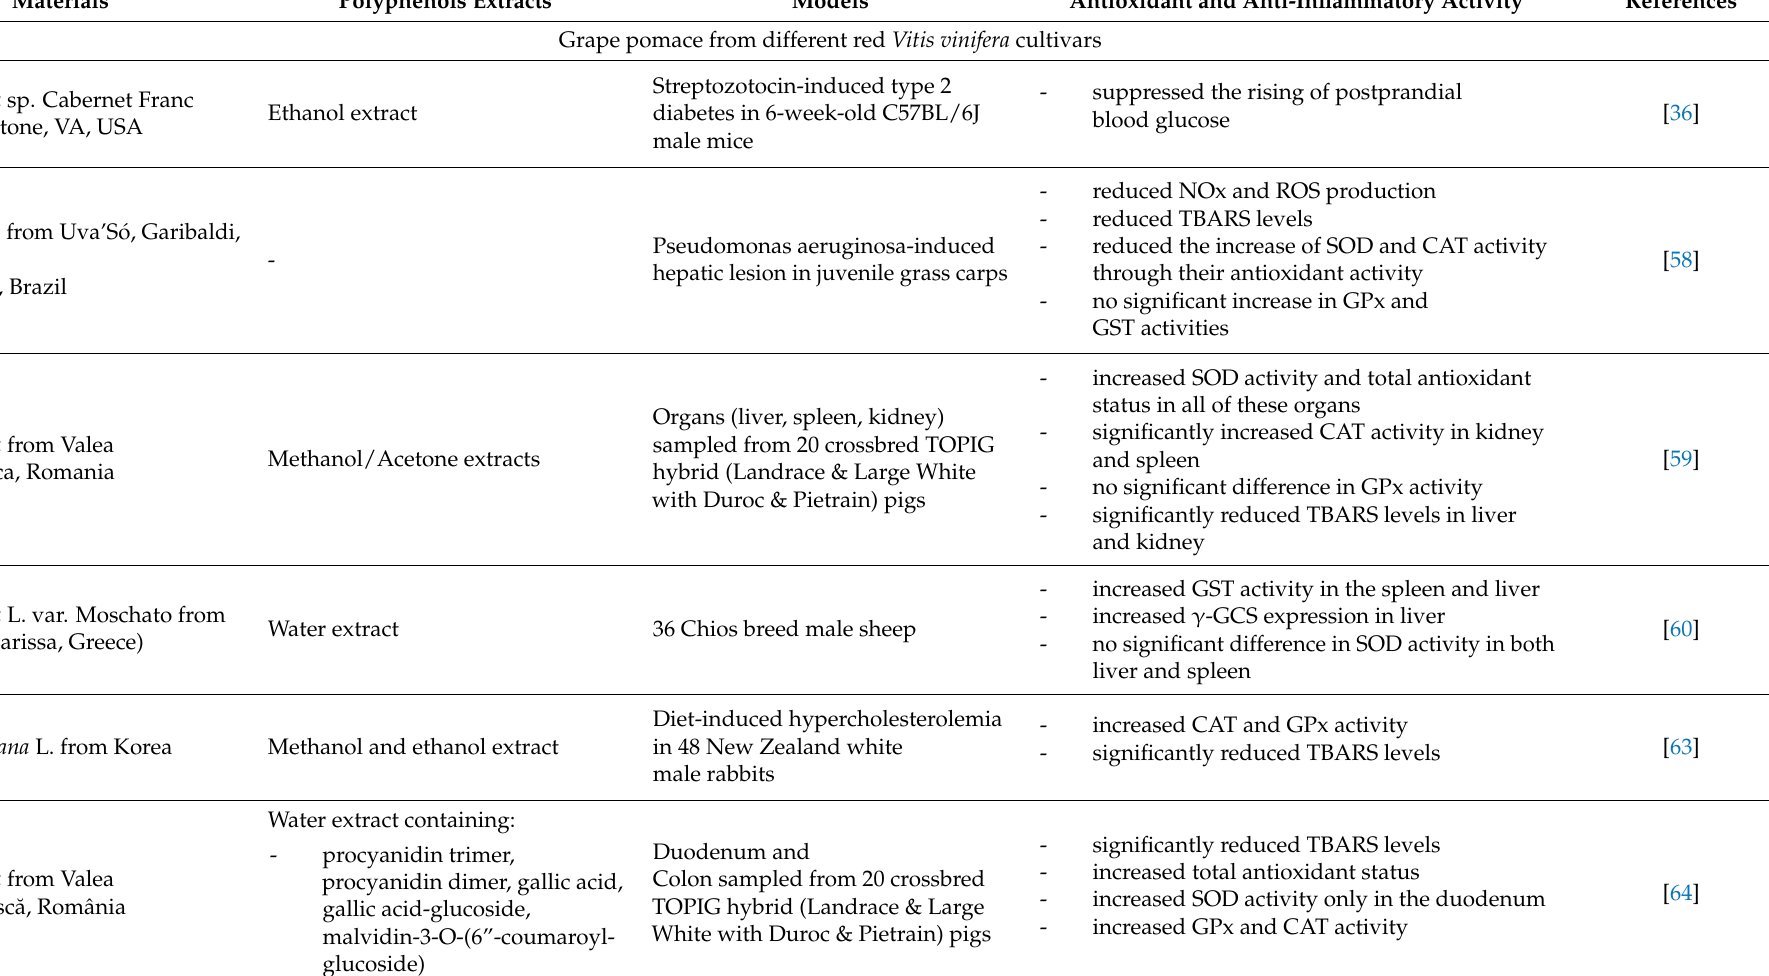
Table 3. In vivo antioxidant and anti-inflammatory activity of grape pomace polyphenols